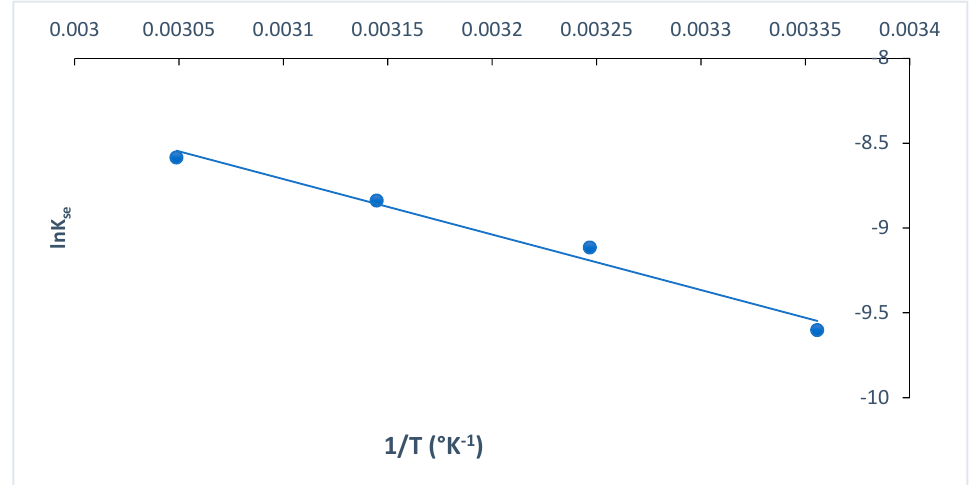
Figure 14. Arrhenius plot for adsorption MB dye onto O -CM-chitosan hydrogel.